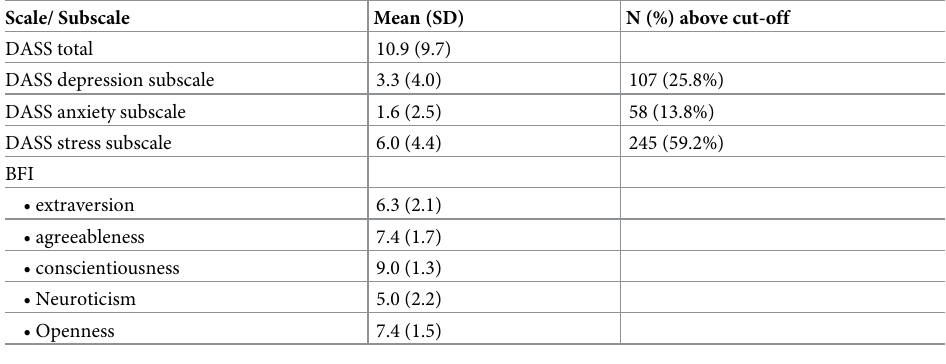
Table 2. Mean scores on scales measuring depression, anxiety and stress (DASS) and personality traits (BFI).